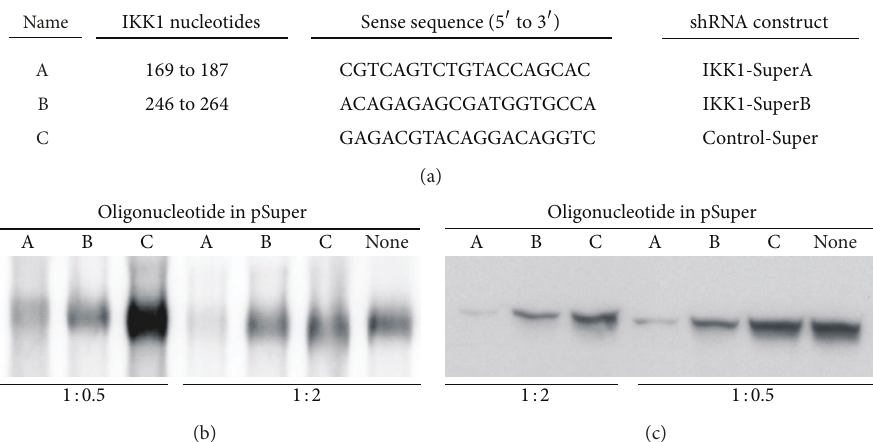
Figure 1: IKK1 silencing in HEK293T transiently transfected cells. (a) Sequences included in pSuper plasmid vector for the production of shRNAsdesignedtoknockdownIKK1expression.TwoIKK1specificoligonucleotides(AandB)andonecontrolscrambledsequence(C)were cloned in pSuper and tested in transfected cells. Nucleotide numbers refer to RefSeq: MN 007700.2. (b) Northern blot analysis of transiently transfected HEK293T cells hybridized with a probe specific for IKK1. Plates were cotransfected with a plasmid for the expression of IKK1 and the indicated pSuper-derivatives; “none” indicates that an empty plasmid was used. (c) Western blot analysis of IKK1 produced in transfected cells. In (b) and (c), each lane contains pooled RNAs or proteins extracts from two different plates. Ratios between the IKK1 expression